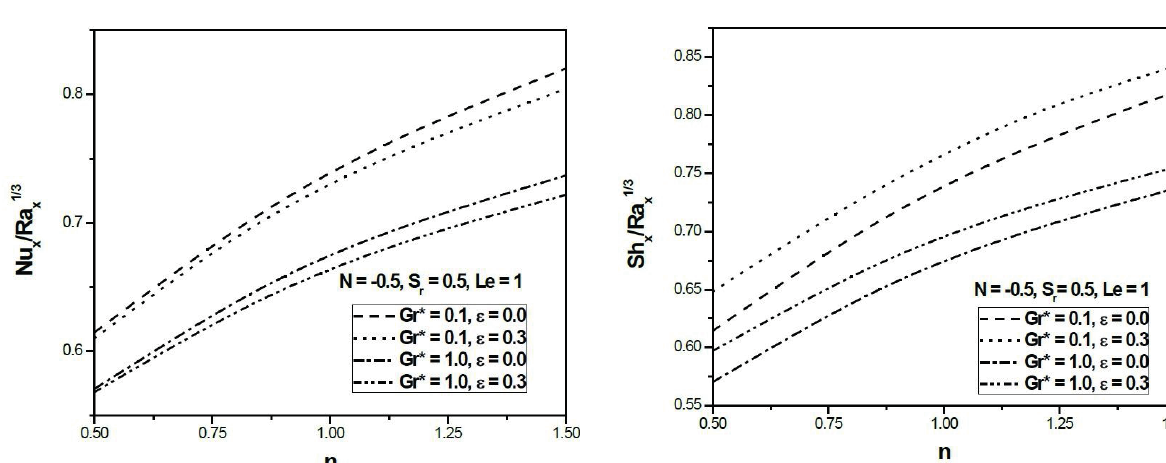
Fig. 7: (a) Variation of concentration profiles against η for n = 0.5 (Opposing Buoyancy); (b) Variation of concentration profiles against η for n = 1.5 (Opposing Buoyancy)